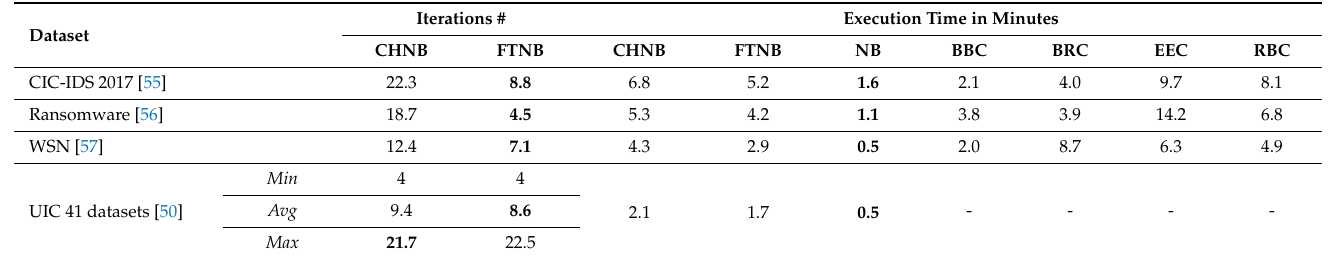
Table 9. Average number of iterations for fine-tuning methods and execution time for the